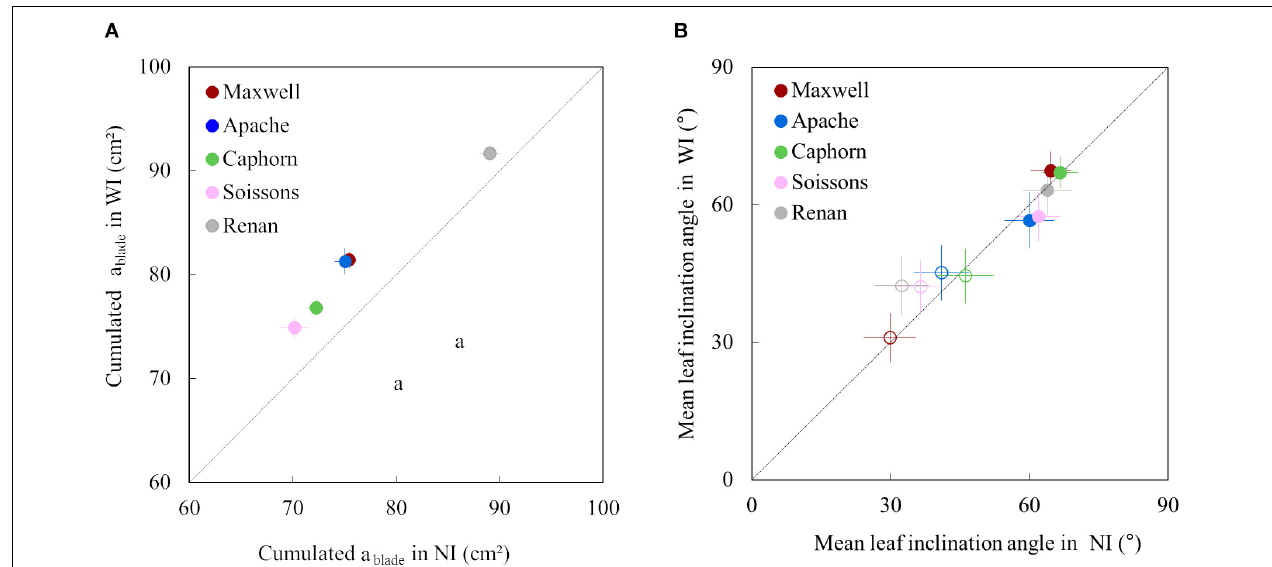
FIGURE 6 | The cumulative area of the four upper blades of the main stem (A) and the mean leaf inclination angle α (B) in WI treatments vs. NI treatments. Each color is associated with a cultivar, as indicated in the legend. The dotted line represents the line 1:1. In (A) , symbols represent the mean of values measured on 45 plants per treatment; error bars mark the 95% confidence intervals of the mean estimates. In (B) , empty symbols represent measurements at the start of stem extension (722 ◦ Cd) while full symbols represent measurements close to ear emergence (1272 ◦ Cd); error bars mark the quarter of standard deviation of mean estimates of all triangles representing leaves (to make the figure easier to